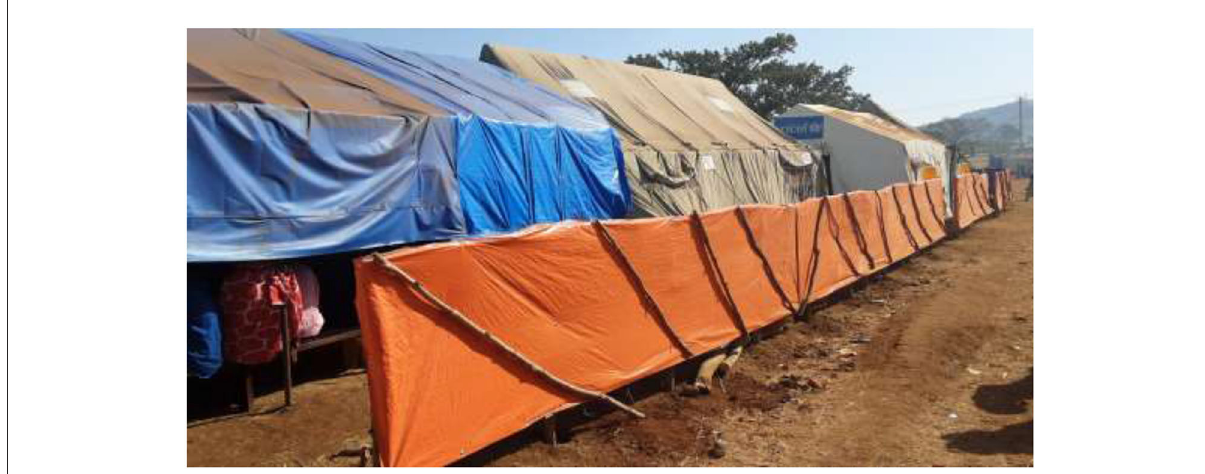
FIGURE3 Layout of Ranch temporary clinic, Changi, Ethiopia, November 2020 up to June 2021.